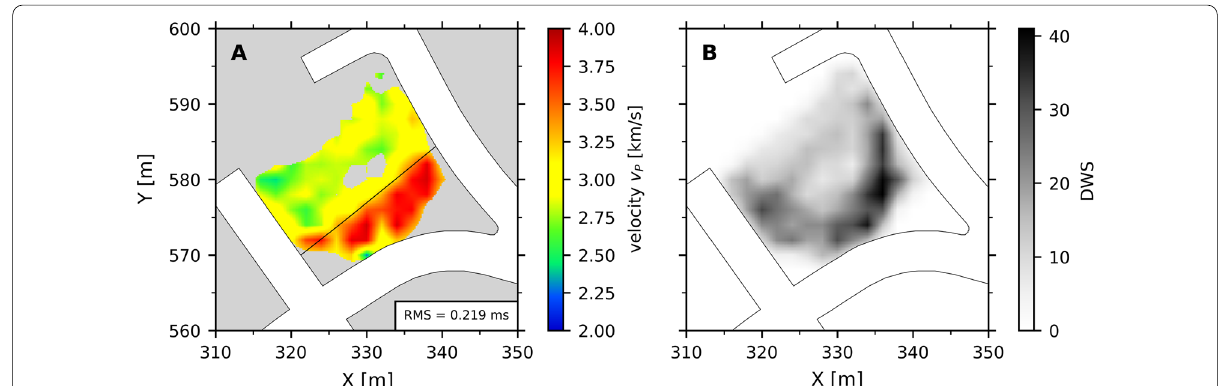
Fig. 6 Tomography of P-wave traveltimes. A velocity model. B DWS. The black line in A indicates the transition between shaly and carbonate-rich sandy facies facies at height of the inversion plane. The outline of the tunnel is shown as white polygon in all